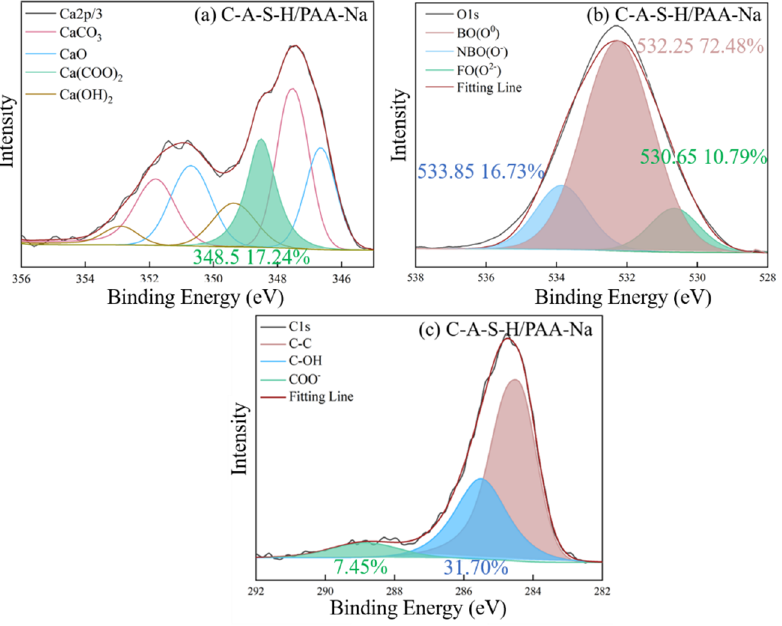
Figure 17. The XPS deconvolution spectrum of ( a ) Ca 2p/3, ( b ) O1s and ( c ) C1s of C ‐ A ‐ S ‐ H/PAA ‐ Na.